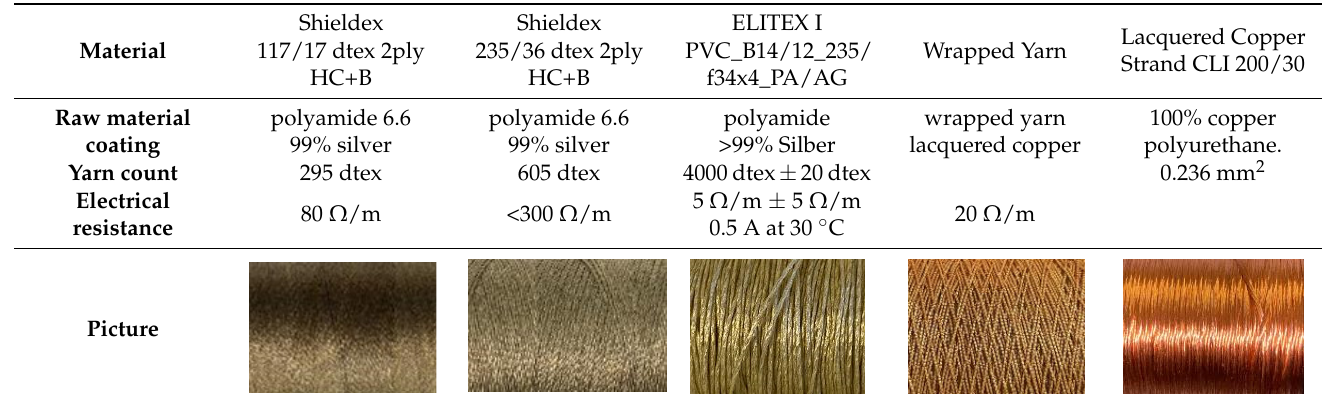
Table 1. Material data of the conductive wire/yarn.